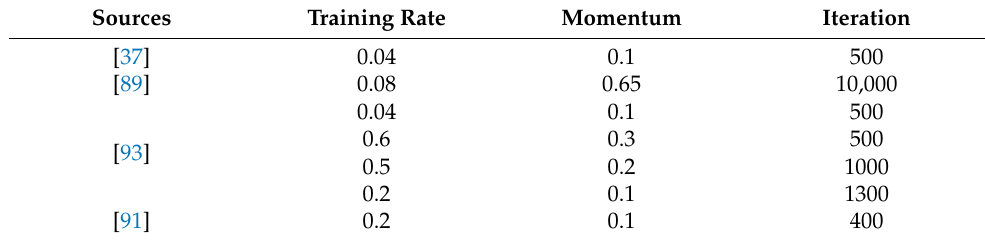
Table 10. Summary on the settings of back-propagation ANNs.